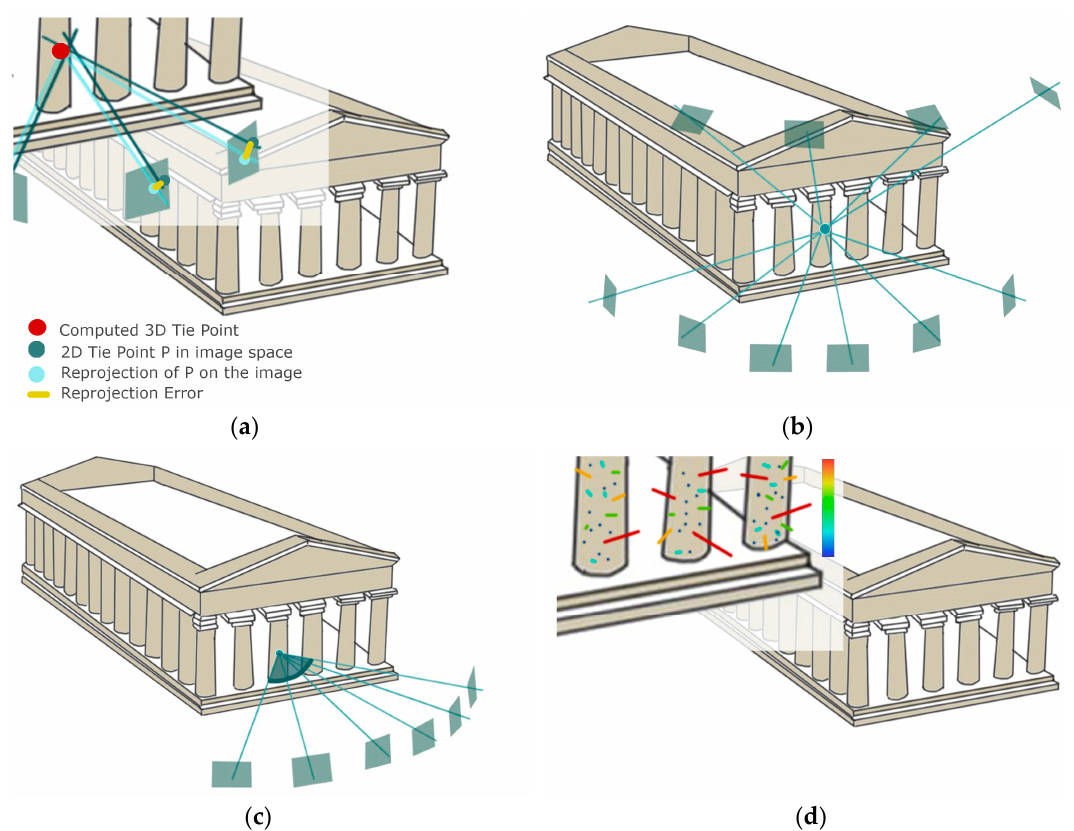
Figure 4. A graphical representation of the considered quality features computed for each 3D tie point: ( a ) re-projection error; ( b ) multiplicity; ( c ) intersection angle; ( d ) a-posteriori standard deviation.